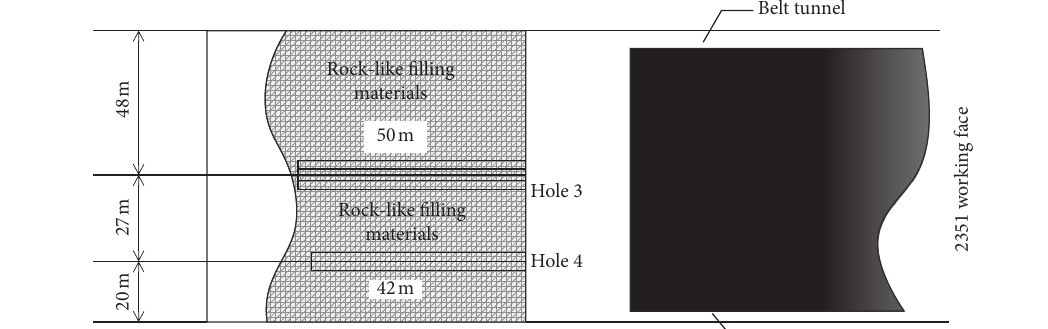
Figure 4: Evaluation matrix of various factors.